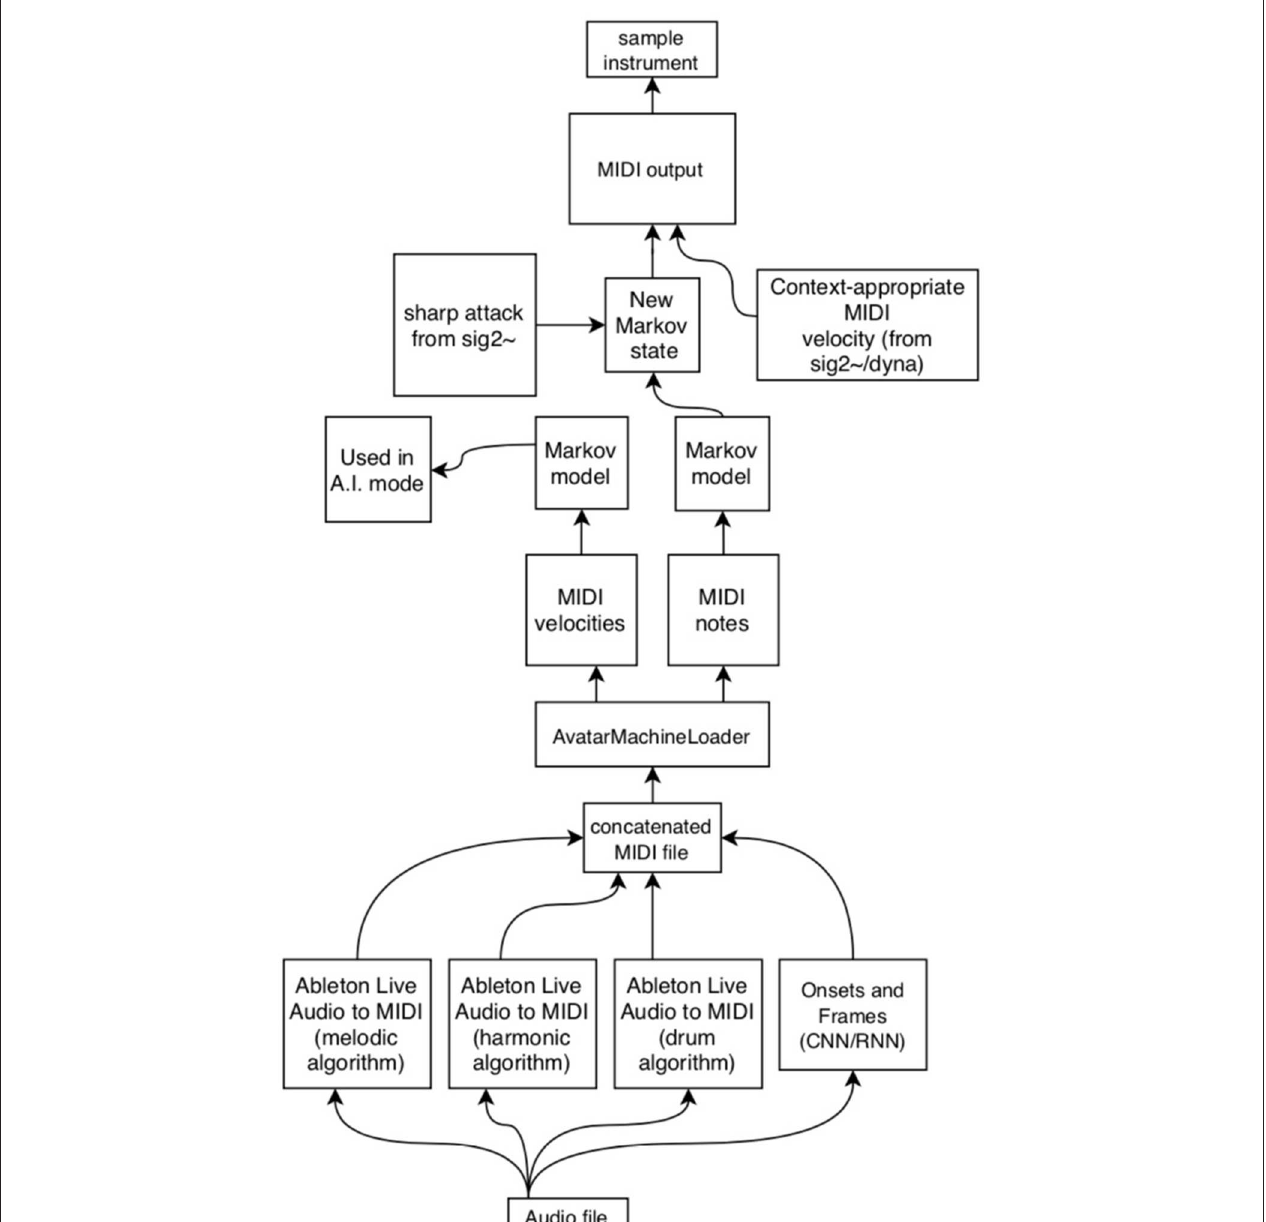
FIGURE 12 | A schematic of how various machine learning technologies are used to create a Markov state transition table for a given